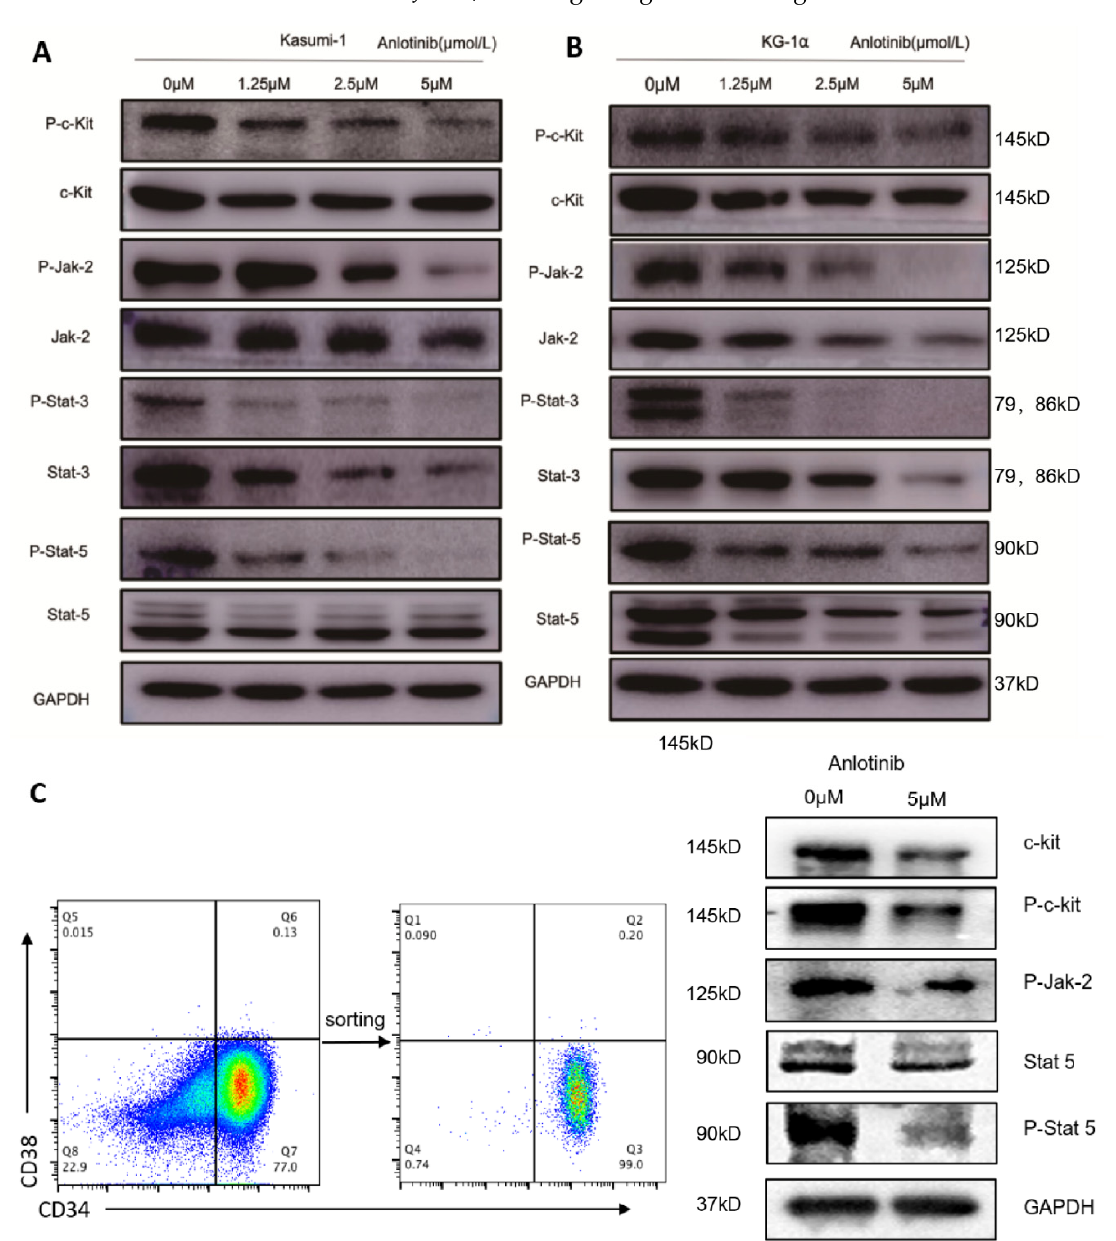
Figure 4. Effects of anlotinib on JAK/STAT signaling in LSC-like and CD34 + CD38-LSC cells. ( A , B ) Western blot analysis of c-kit, p-c-kit, JAK2, p-JAK2, STAT3, p-STAT3, STAT5, and pSTAT5 in Kasumi-1 cells ( A ) and KG-1 α cells ( B ) after anlotinib treatment with indicated concentration for 12 h. ( C ) Western blot analysis of c-kit, p-c-kit, p-JAK2, STAT3, p-STAT3, STAT5, and pSTAT5 after anlotinib treatment with indicated concentration for 12 h.